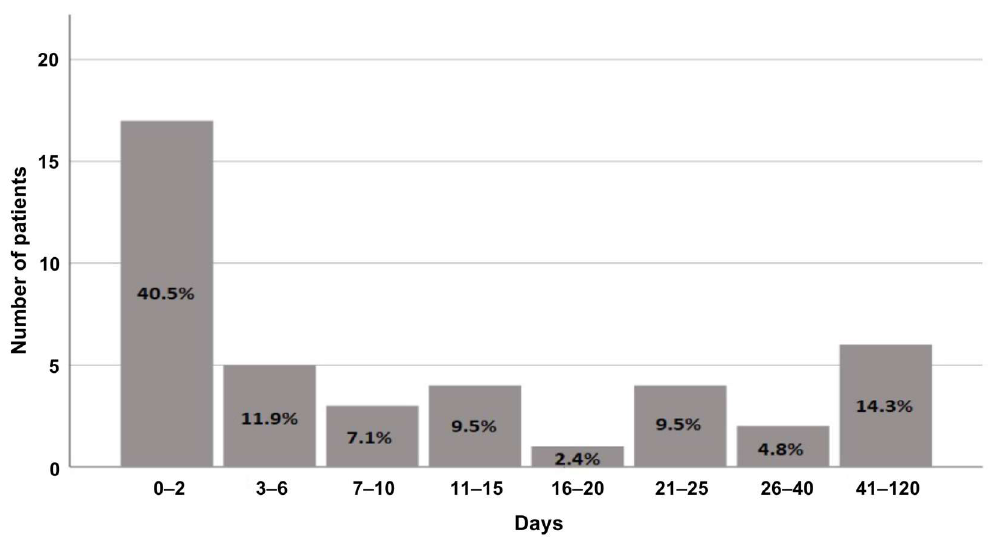
Figure 1. Time between preoperative nutritional consultation and surgery.